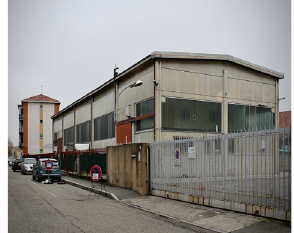
Fig. 8 Example of industrial architecture of the 20 th